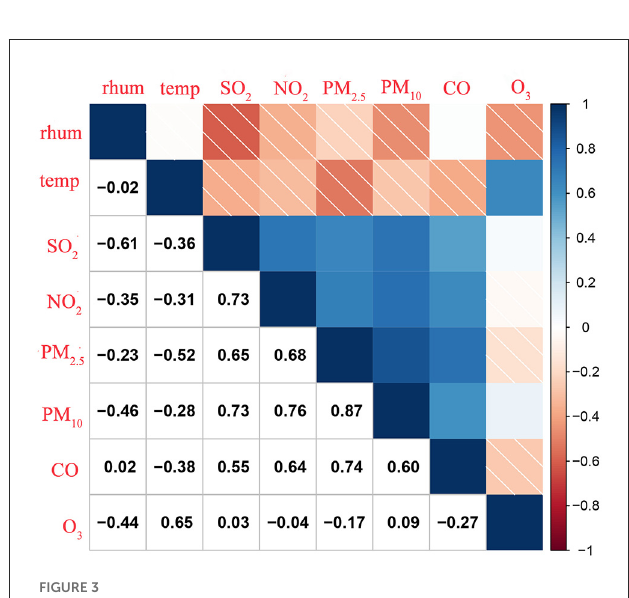
FIGURE3 Spearman correlations among exposure variables in Wuhan, China (2016–2018). temp, Temperature; rhum, Relative